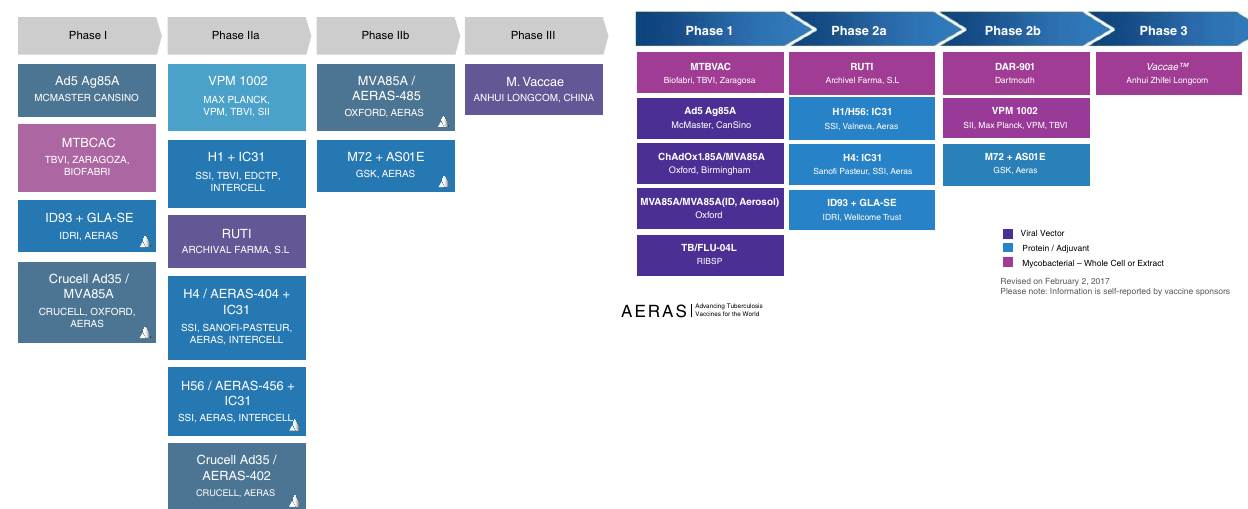
Figure 1. The TB Vaccine Pipeline 2012–2017 (adapted from http://www.aeras.org/pages/global-portfolio).